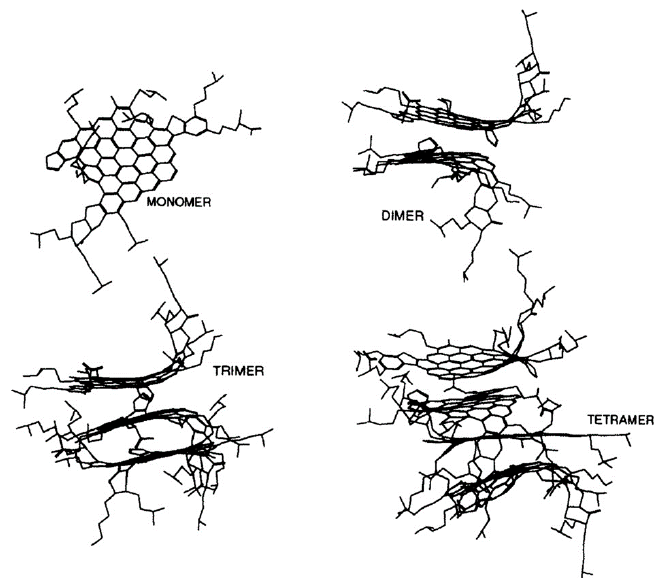
Figure 2. Monomeric, dimeric, trimeric, and tetrameric structure of a Venezuelian asphaltene molecule (reprinted from [28] with permission of the American Chemical Society).